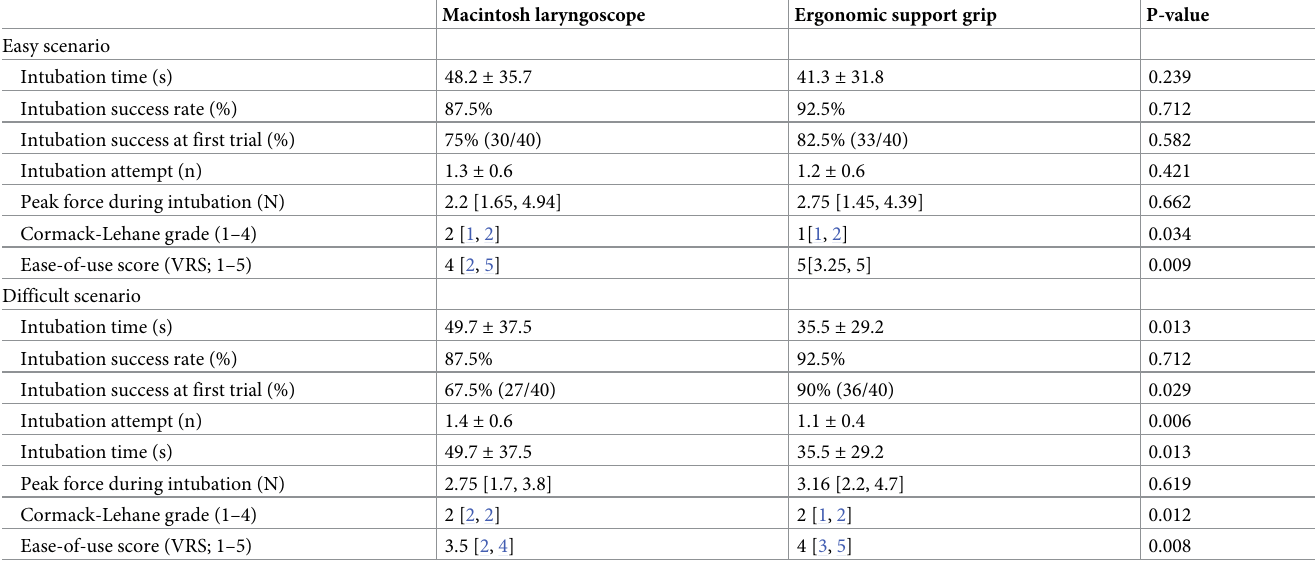
Table 1. Performance data for novices using a Macintosh laryngoscope with and without the ergonomic support grip for easy and difficult airway